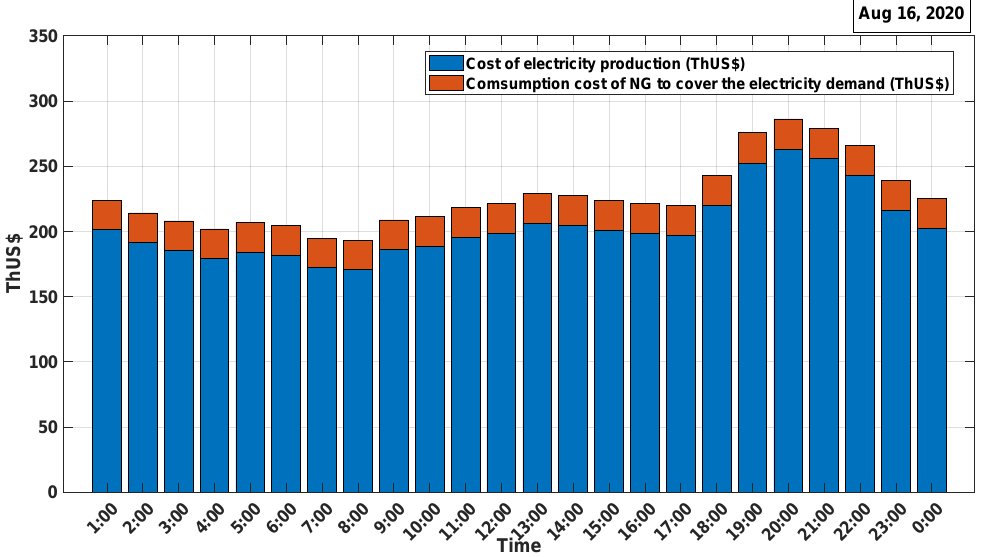
Figure 13. Optimal cost of energy production and ng supply and operation of the integrated gas– electricity system—stage